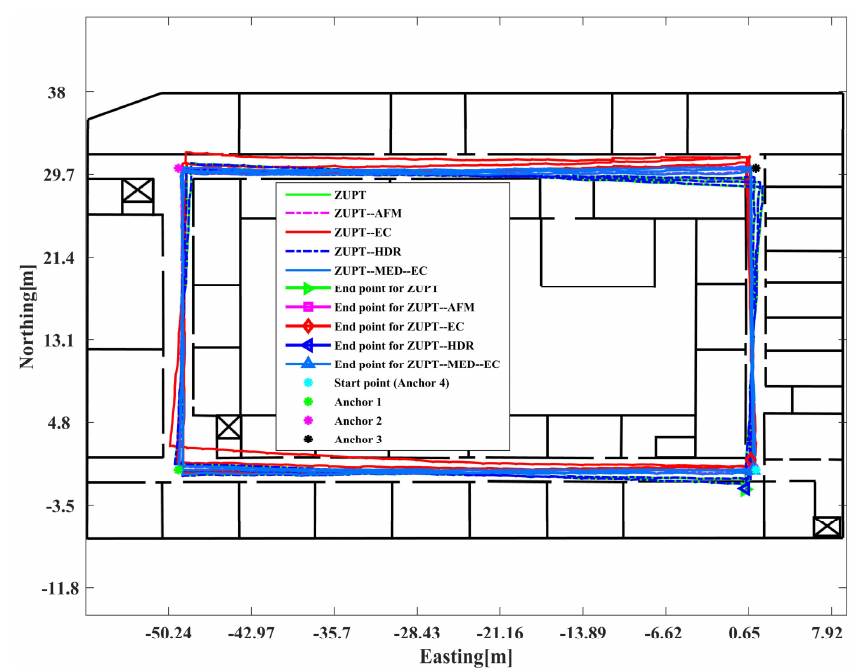
Figure 12. Trajectories estimated by the different algorithms using the indoor three-lap walking